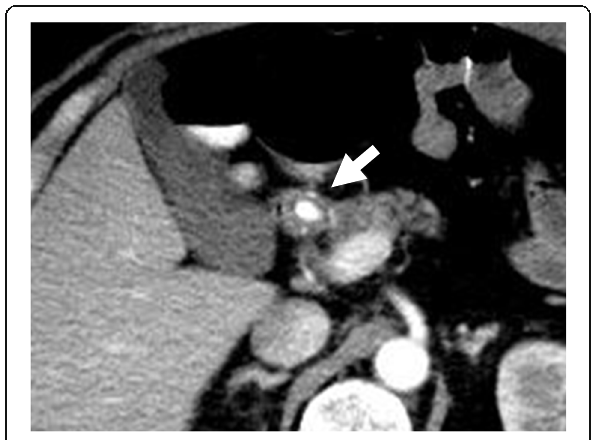
Fig. 4 Abdominal dynamic contrast-enhanced computed tomography (CT) findings. Dynamic CT showing a pseudoaneurysm arising from the proximal gastroduodenal artery